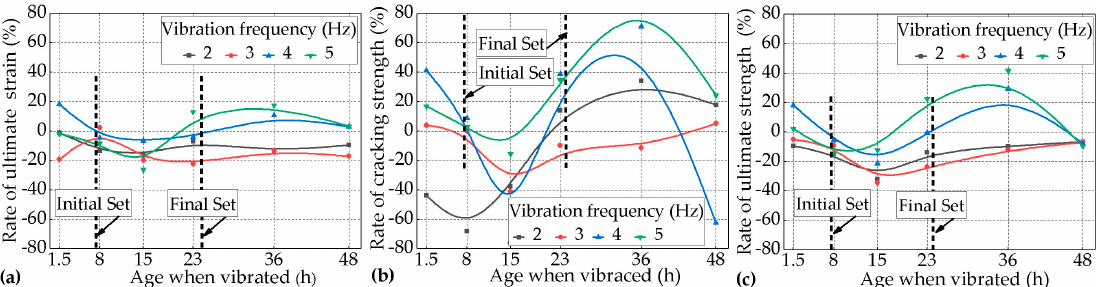
Figure 5. Rates of ( a ) the ultimate tensile strain, ( b ) the cracking strength, and ( c ) the ultimate tensile strength for the vibrated groups over the control group with the increase of the age when vibrated subjected to the combination of different levels of frequency and a constant duration of 5.0 h.